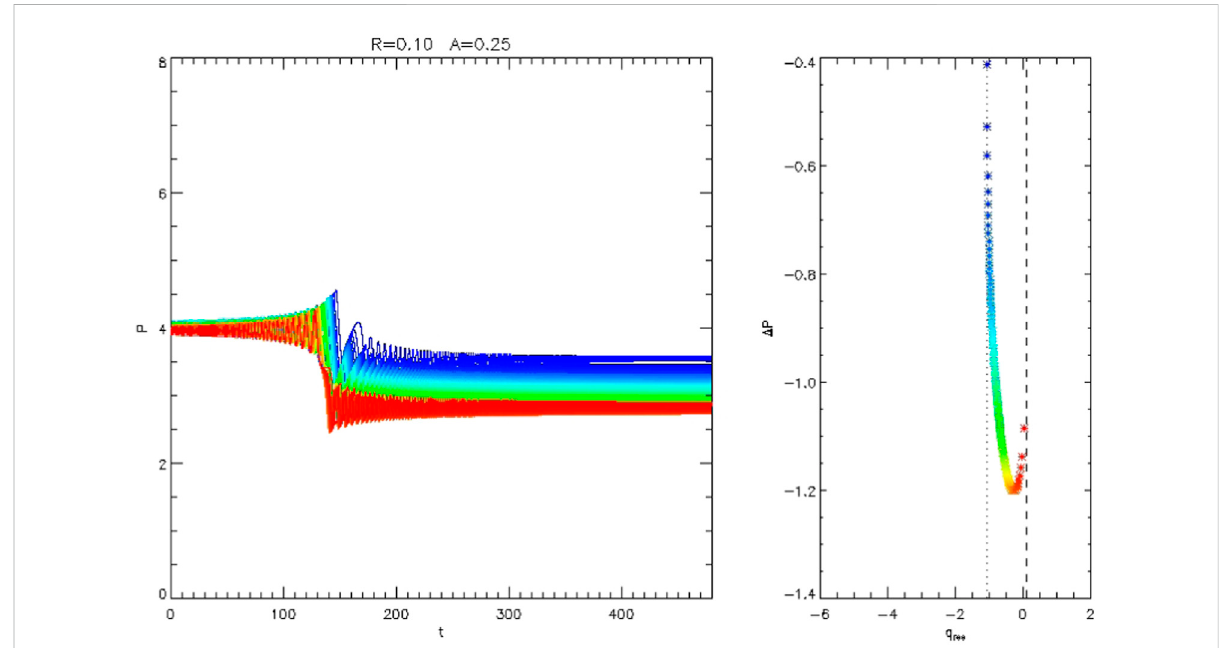
FIGURE 1 Trajectories of 120 particles from numerical integration of the equations of motion speci fi ed by the Hamiltonian of Eq. 11, with inhomogeneity parameter R = 0.1 and wave amplitude parameter A = 0.25. Left: P vs. t , showing systematic decrease associated with phase bunching at resonance. In this case, all values of Δ P are negative. Right: Change in P vs. the value of q atresonance. The dotted and dashed vertical lines show the calculated values q turn and q x + 2 π , respectively, as discussed in the